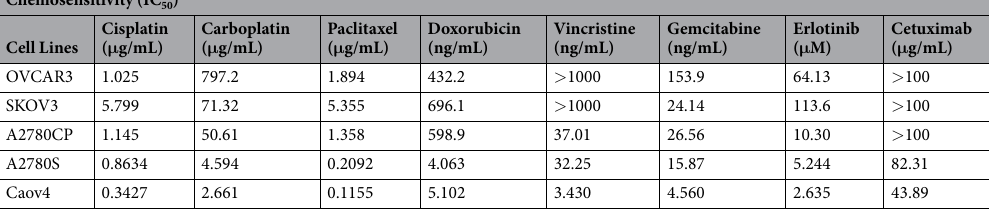
Table 1. Chemosensitivity of a panel of EOC cell lines to certain chemotherapeutics and targeted therapies. Data represent the average of IC 50 values and were collected from three independent experiments, each performed in triplicate. IC 50 is the concentration of drug that caused a 50% reduction in proliferation compared to the vehicle-treated